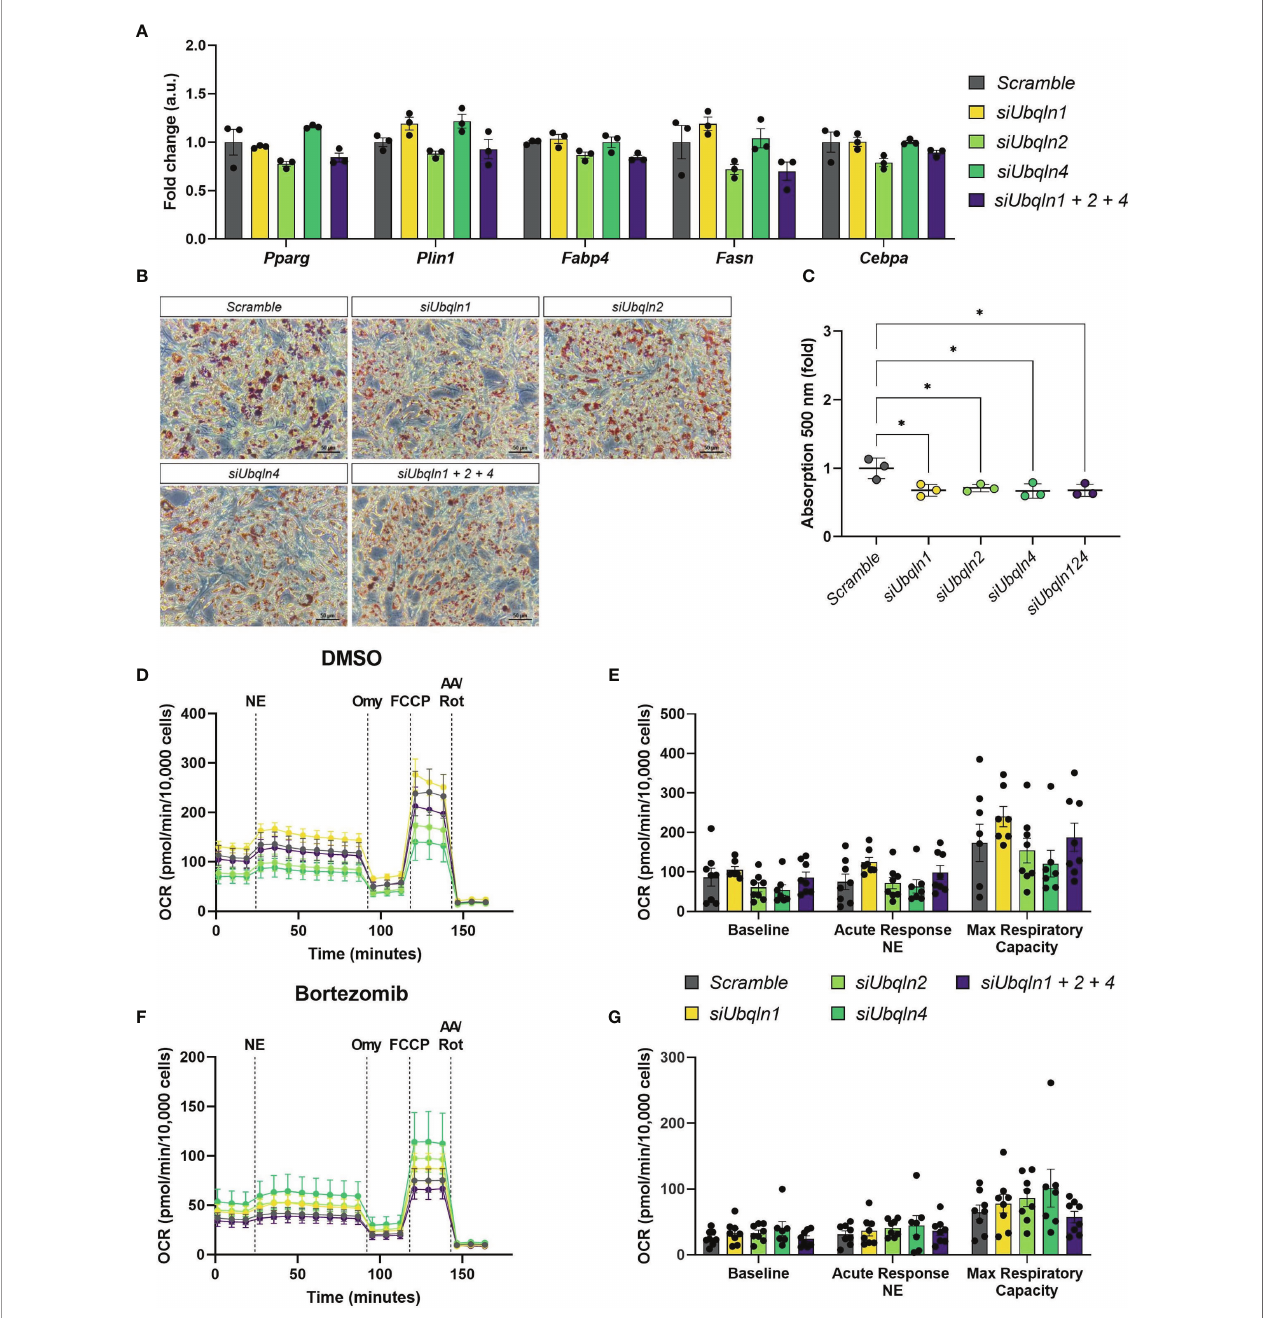
FIGURE 3 | Silencing of Ubqln1, 2 and 4 lowers lipid content but does not impair adipocyte health. Ubiquilins were silenced by siRNA-mediated knockdown in imBAT. (A) , Relative gene expression measured by qPCR ( n = 3 technical replicates mean ± SEM). (B, C) , Oil red O staining and quanti fi cation. (D, E), Oxygen consumption rate (OCR) of imBAT treated with DMSO (control) or (F, G) , 100 nM bortezomib for 6 h. Data are mean ± SEM. ( n = 7-8 technical replicates of 2 independent experiments). *P adj <0.05, **P adj < 0.01, ***P adj < 0.001, ****P adj < 0.0001 by two-way ANOVA versus Scramble with Bonferroni post-hoc test (A, C, E, G)